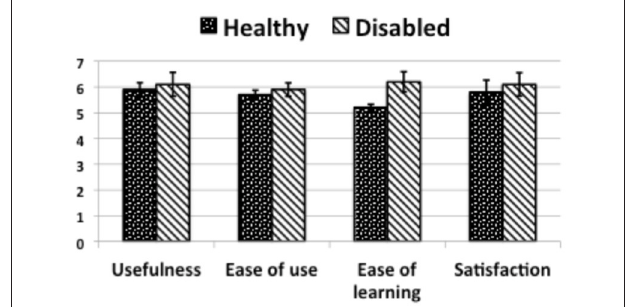
FIGURE 8 | A bar chart summarizing the median answers of the user for each question category across Experiment 1 and 2. The error bars are the 95% bootstrapping confidence intervals.